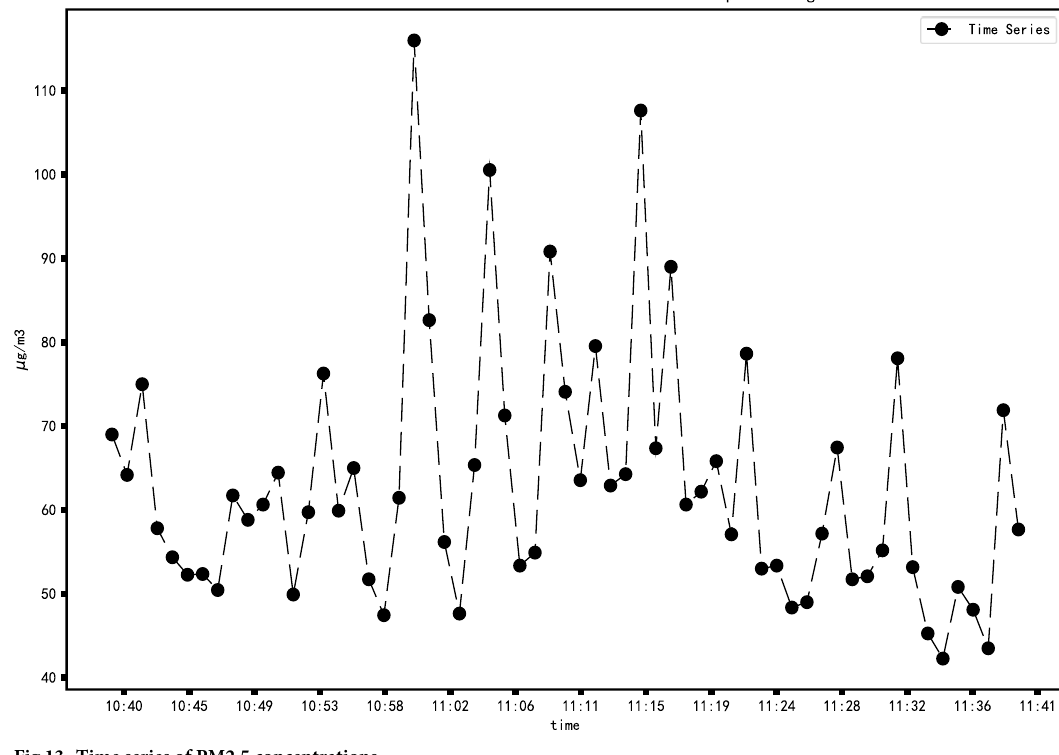
Fig 13. Time series of PM2.5 concentrations.